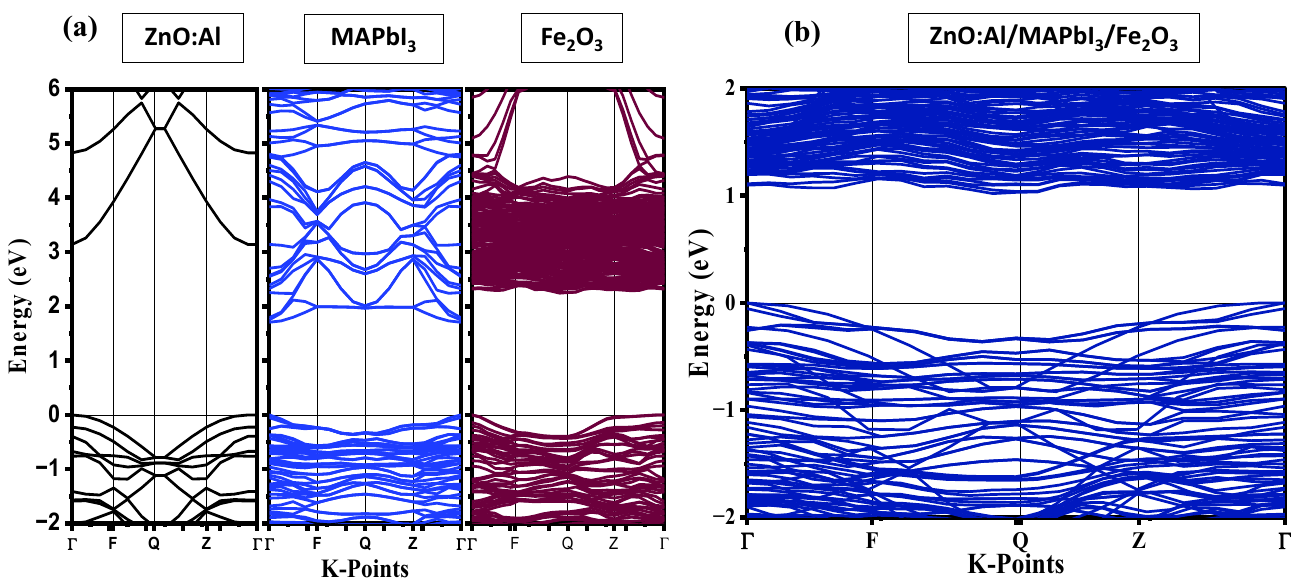
Figure 1. Calculated energy band structures of ( a ) freestanding ZnO:Al, MAPbI 3 , and Fe 2 O 3 , and ( b ) the Fe 2 O 3 /MAPbI 3 /ZnO:Al heterostructure based on GGA-PBE. The Fermi level is set to be 0 eV and denoted by a black line.